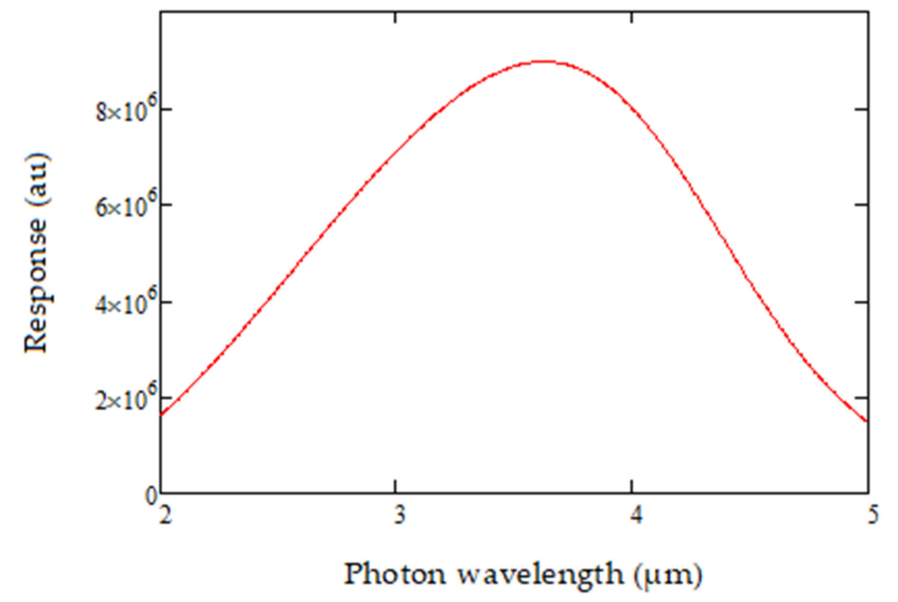
Figure 8. Source-Detector product over the detection range of